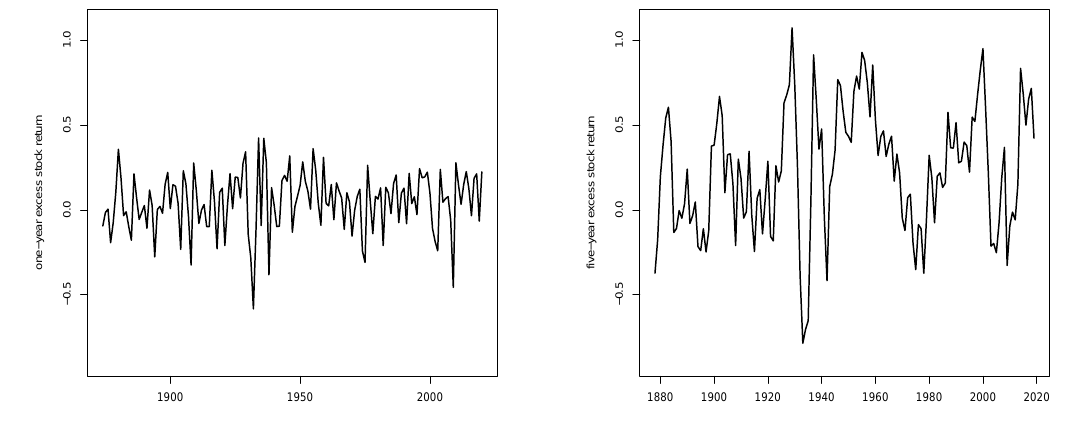
Figure 2. ( Left ) one-year stock returns in excess of the risk-free benchmark. ( Right ) five-year stock returns in excess of the risk-free benchmark. Period: 1872–2019. Data: annual S&P